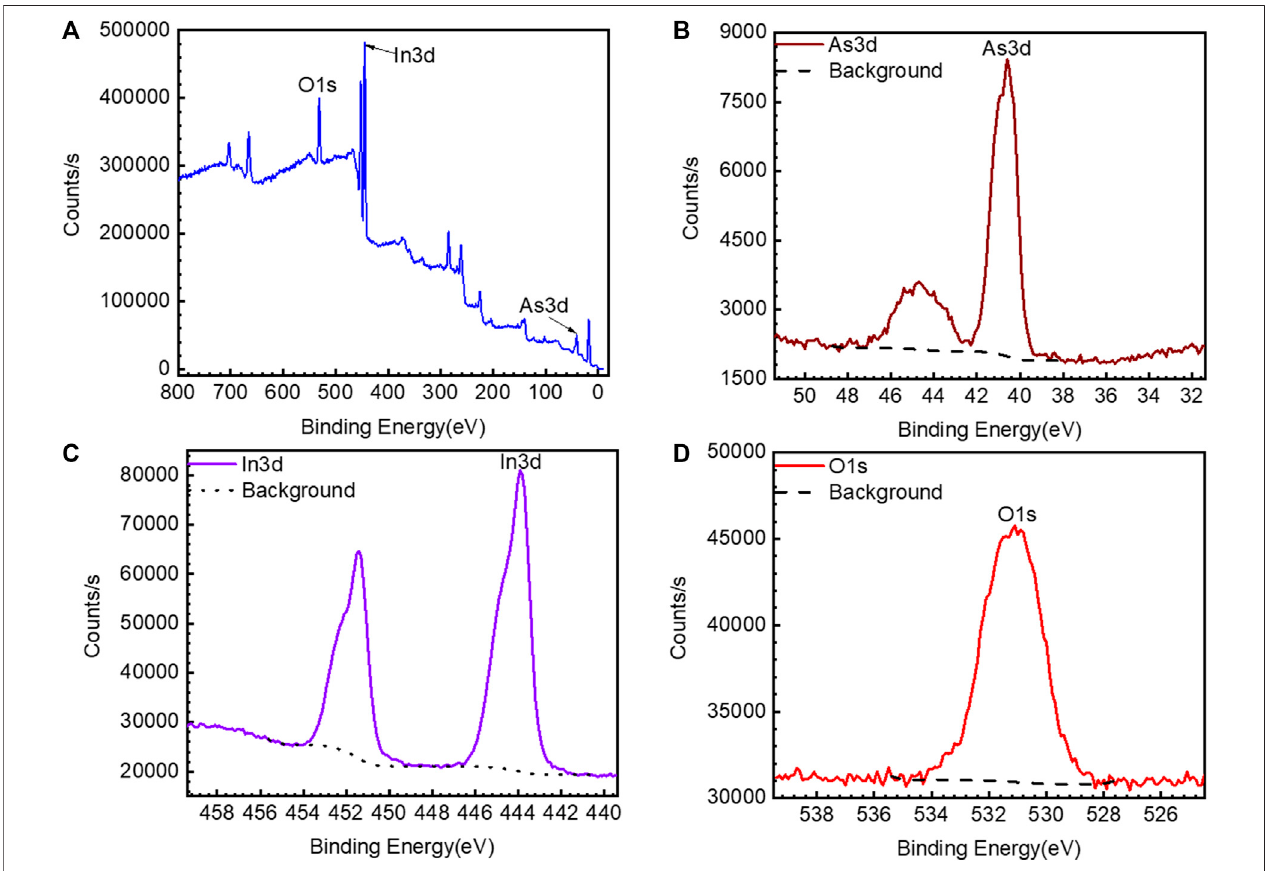
FIGURE 5 | (A) High-resolution XPS spectra of InAs NWs. XPS spectra of (B) As3d and (C) In3d. (D) O1s for InAs NWs.